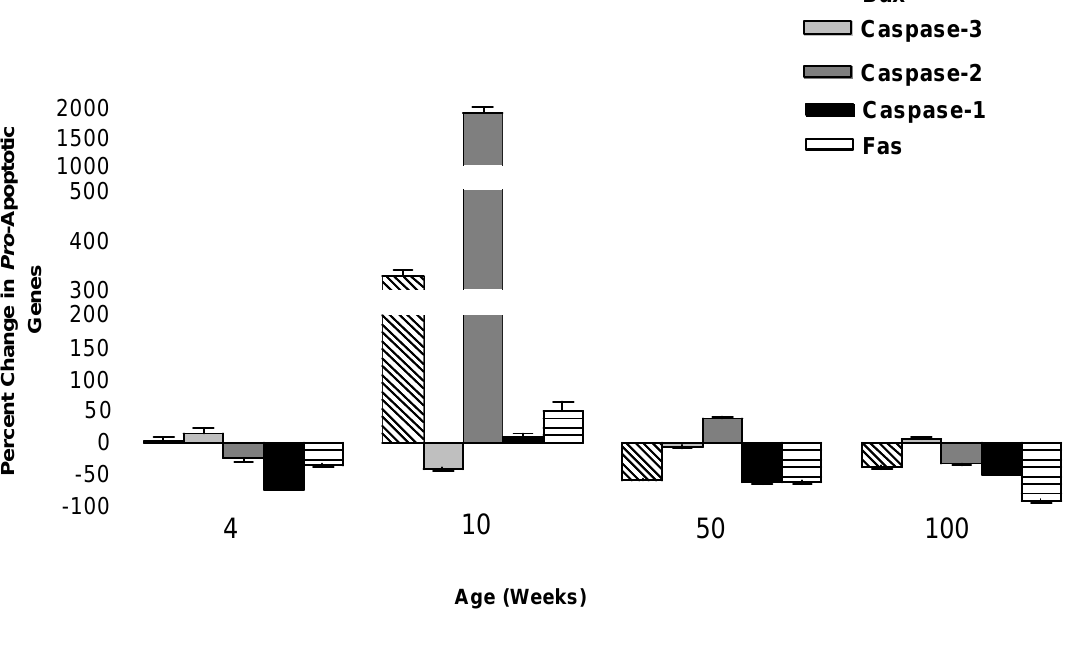
FIGURE 4. Effect of age on elements of the hepatic proapoptotic machinery. mRNA of various proapoptotic factors were quantified by ribonuclease protection assay and normalized against L 32, and percent change from respective untreated values were calculated. Data are means + SEM of three animals per